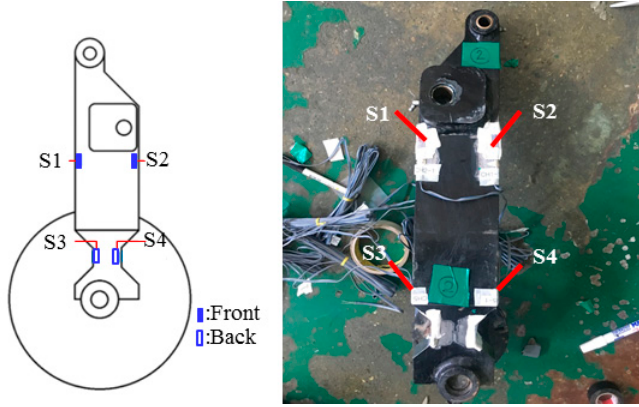
Figure 3. Strain gauge locations of disk harrow arm.